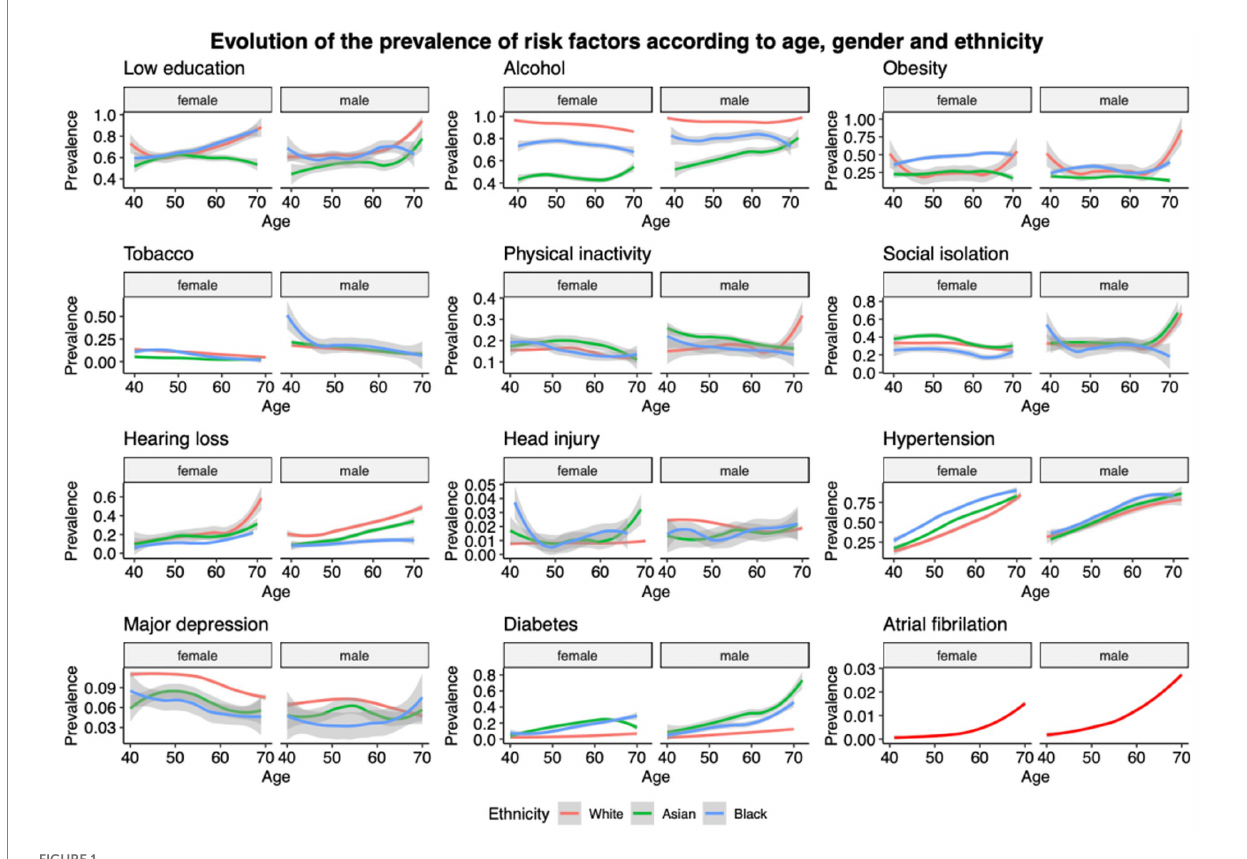
FIGURE 1 Repartitions of lifestyle and comorbidities by sex across ages for the different ethnicities. For atrial fibrillation due to the low number of cases in black ( n = 8) and Asian ( n = 8), only white participants’ results are